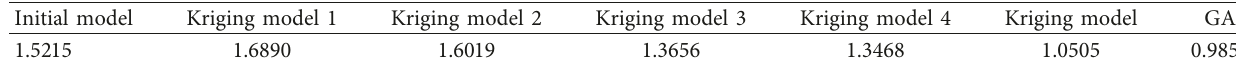
Table 6: Comparison of the error